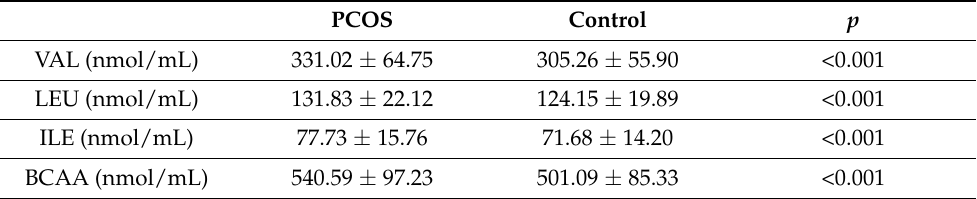
Table 2. Comparison of BCAA plasma concentration between PCOS and control